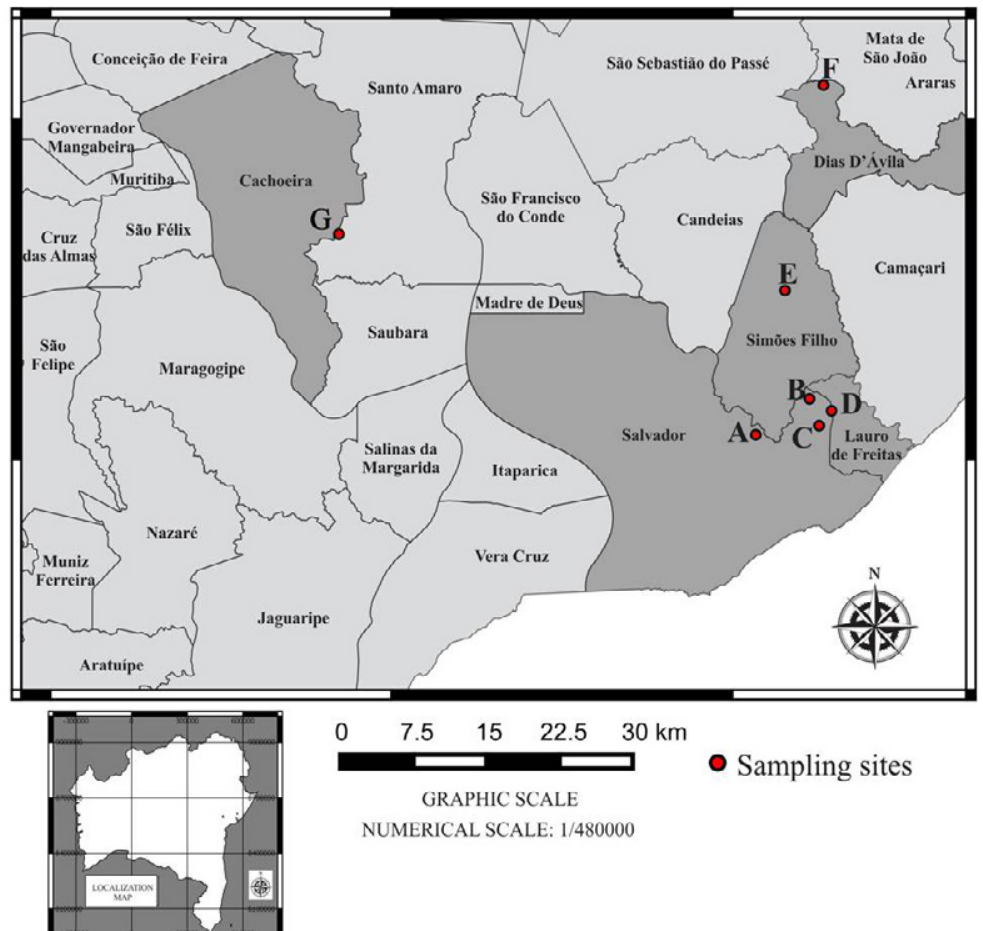
Fig 1 . Geographical location of sampling sites in Salvador and the metropolitan region, state of Bahia,